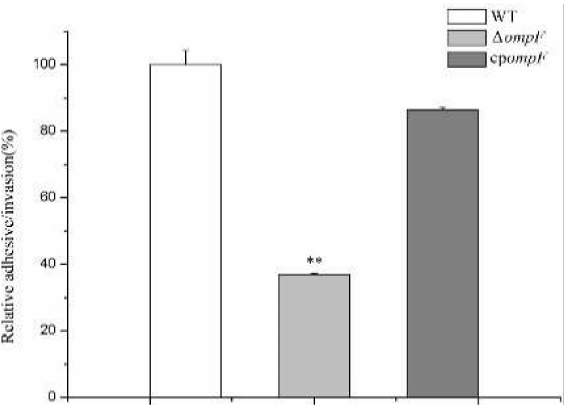
Figure 5. SDS-PAGE analysis of LPS extracted from C. sakazakii WT, ∆ ompF and cp ompF strains.